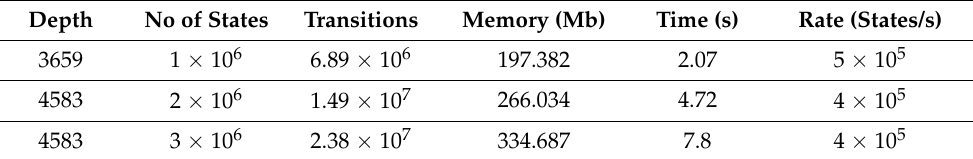
Table 3. Complexity representation of SPIN simulation.